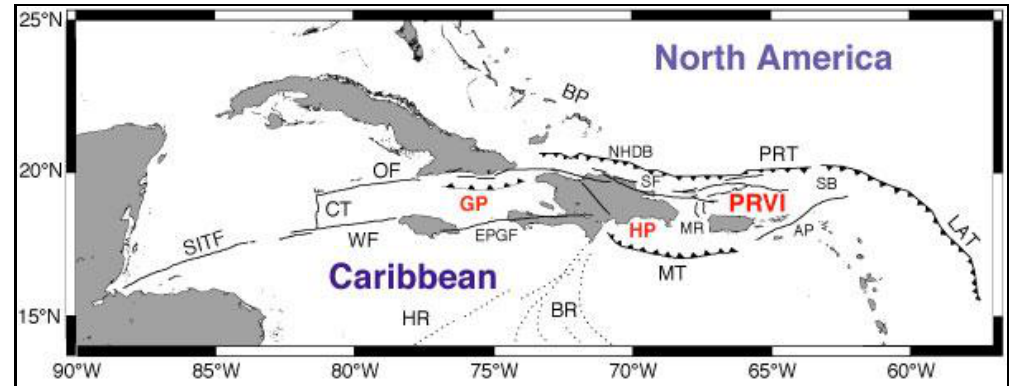
Figure 3. Haiti—Enriquillo-Plantain-Garden-Fault Zone